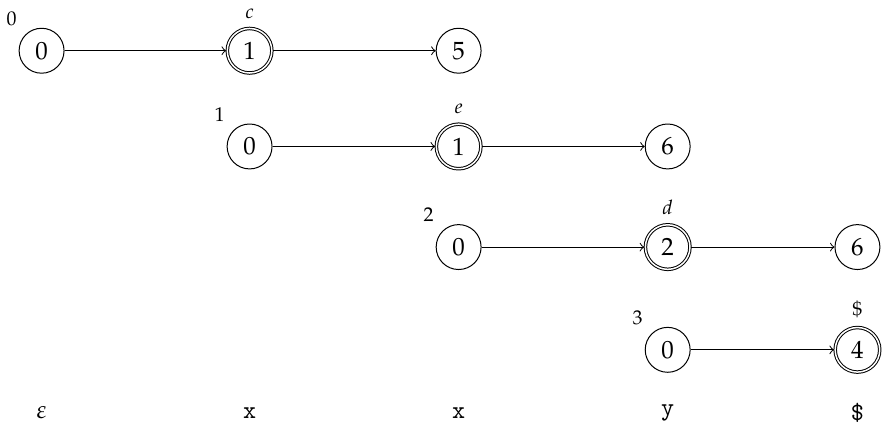
Figure 8. The scanner trace outlining the paths taken through the scanner automaton using the speci- fication Ξ in (2).